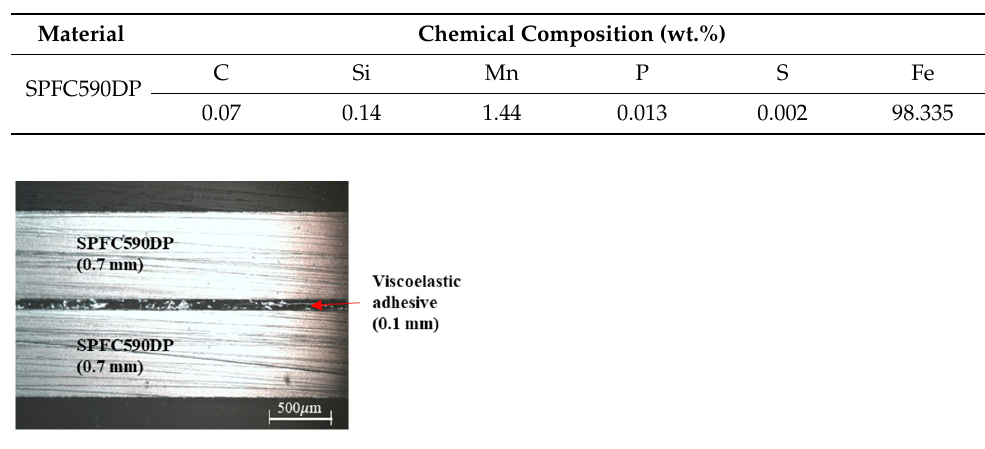
Table 1. Chemical composition of the base steel alloy used in this study.